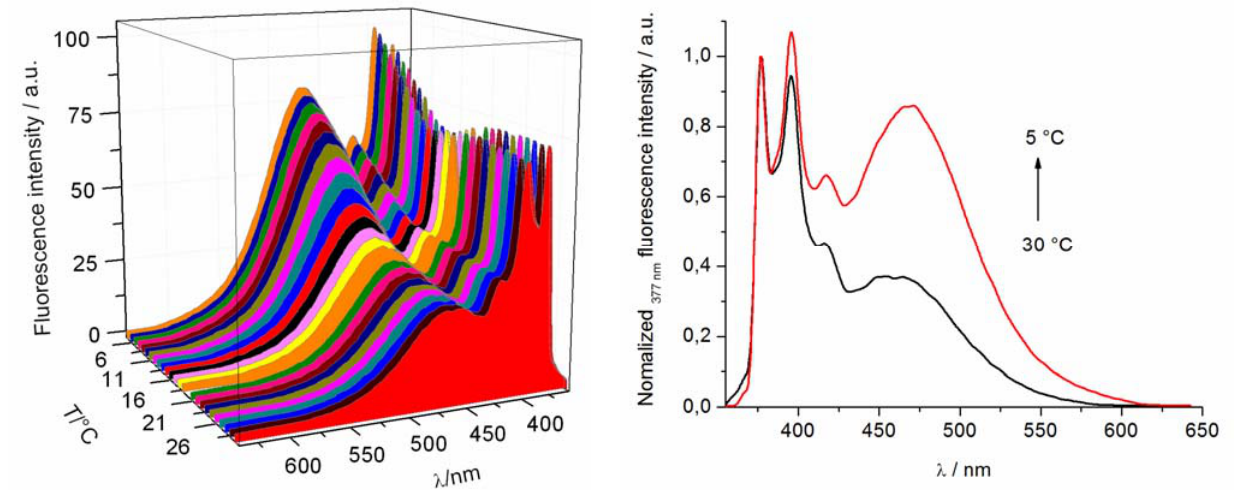
Figure 3. ( a ) Waterfall plot of the fluorescence spectra as a function of temperature (excitation wavelength 342 nm) and ( b ) normalized fluorescence intensity (377 nm) at 5 °C (red) and 30 °C (black) of a solution of pyrene-labeled copolymer 5 in water at 1.0 mg mL − 1